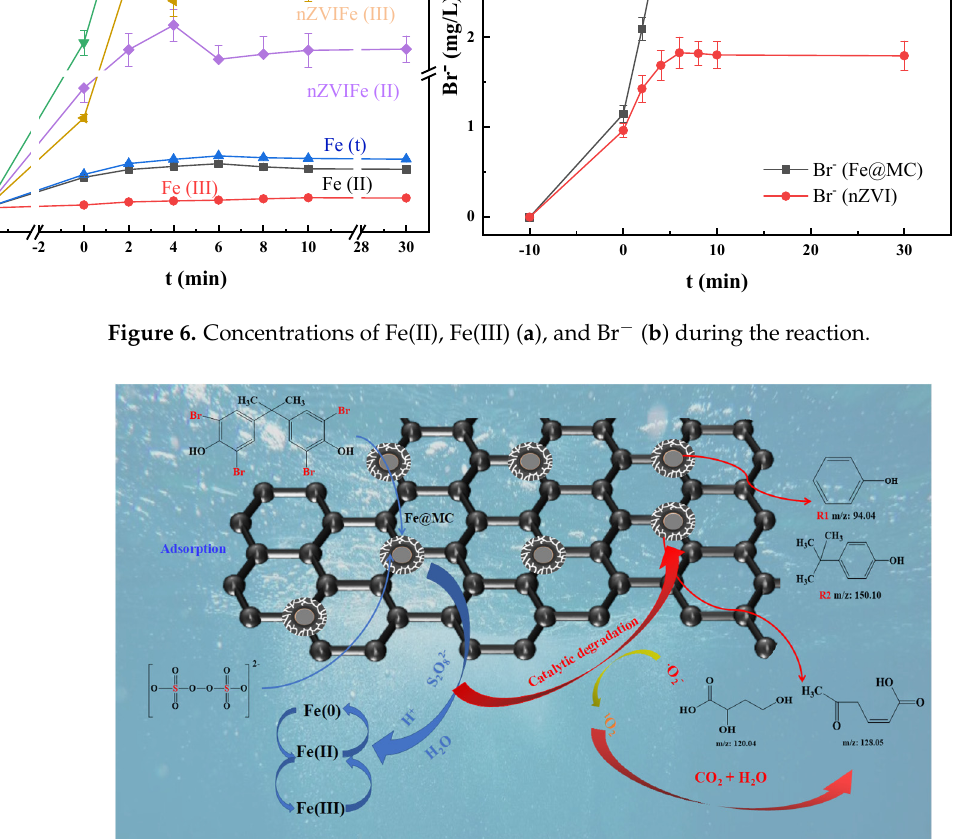
Figure 7. Degradation mechanism of TBBPA in the Fe@MC/PS system.